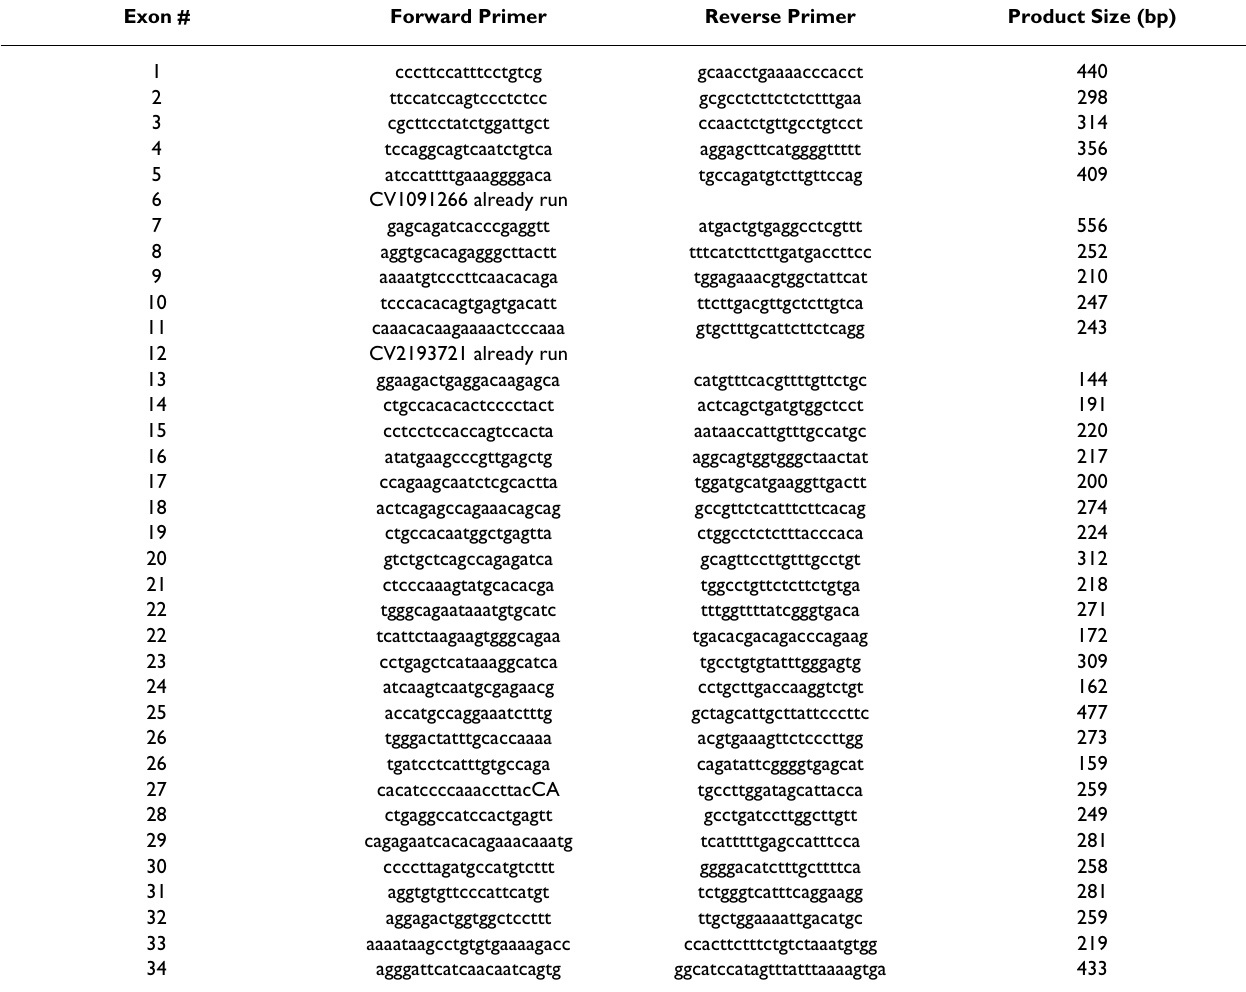
Table 2: LAMB1 exonic screening primer pairs. Capital letters indicate sequence within an exon. SNP assays were already run in the initial association studies using SNPs in exons 6 and